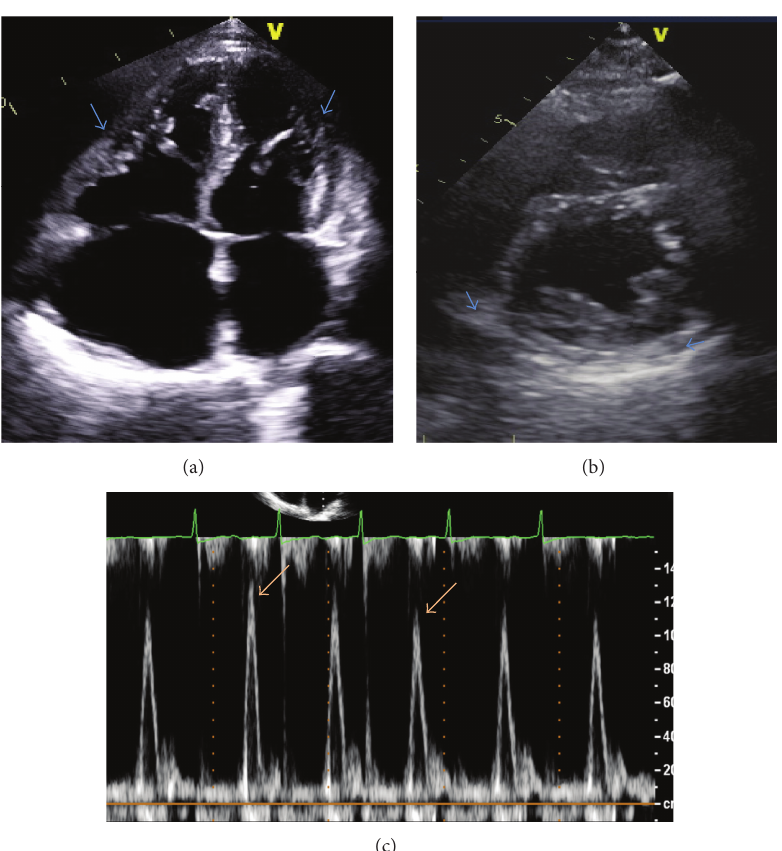
Figure 2: (a), (b) Transthoracic echocardiogram (apical (a) and parasternal short-axis (b)) showing resolution of pericardial effusion (blue arrows) after 10 weeks of IV Penicillin. (c) Pulsed-wave Doppler interrogation of mitral valve inflow on transthoracic echocardiogram: normal variation of mitral valve E velocity (orange arrows), suggesting normalization of pericardial